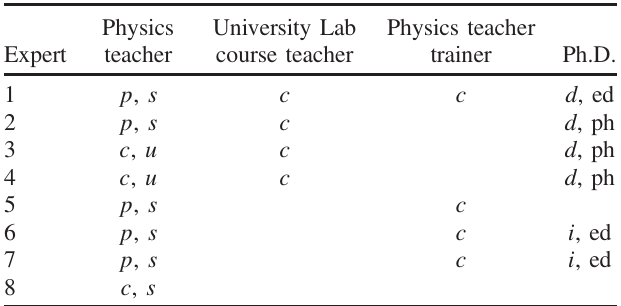
perts in terms of four expert criteria. The symbols p , c , and i denote that the criterion was satisfied in the past, currently or in progress, respectively. Symbols s and u denote secondary school level and university level, and d denotes a Doctorate in physics or in physics